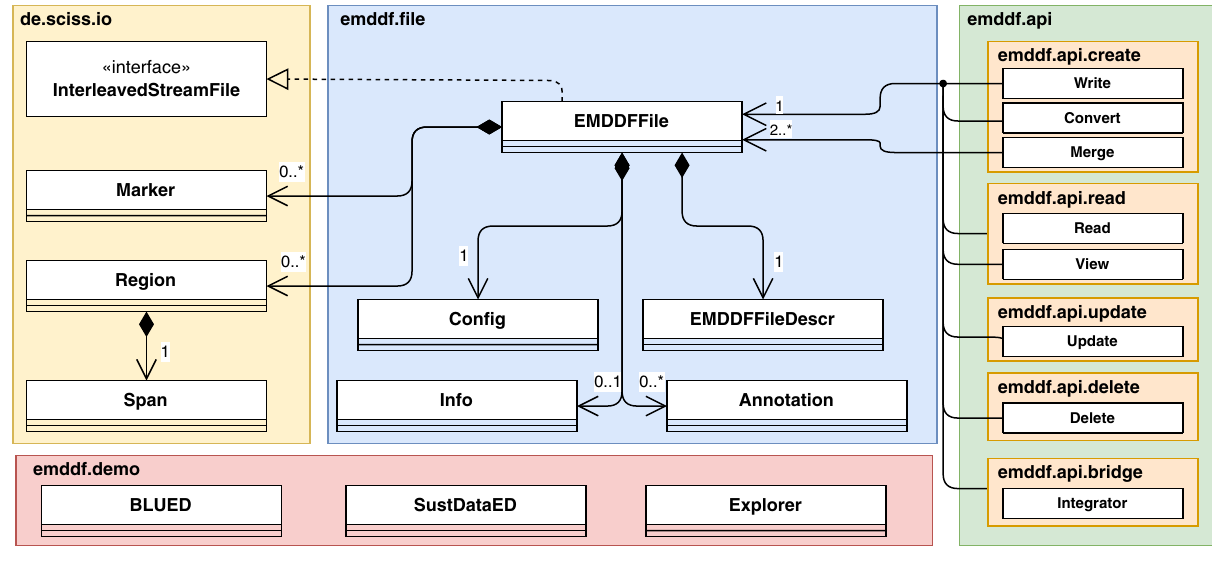
Figure 3. EMD-DF64 class diagram.